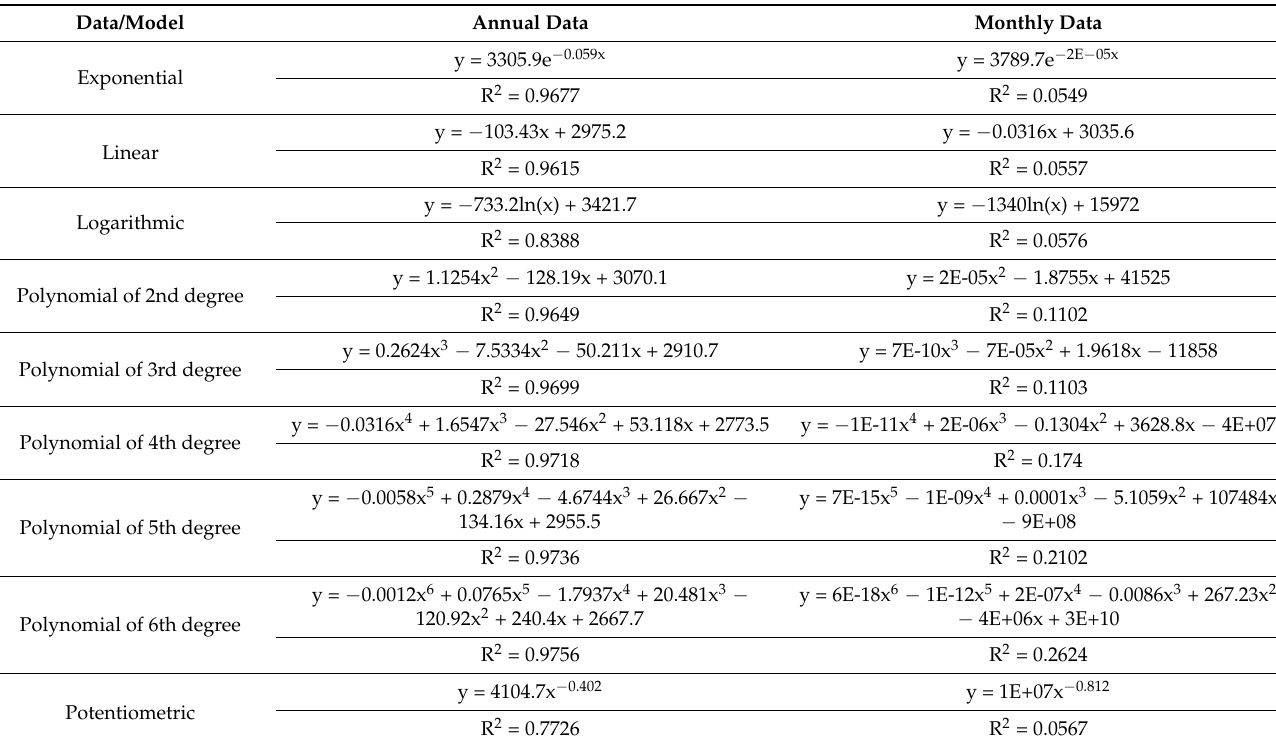
Table A3. Trend models for Lublin